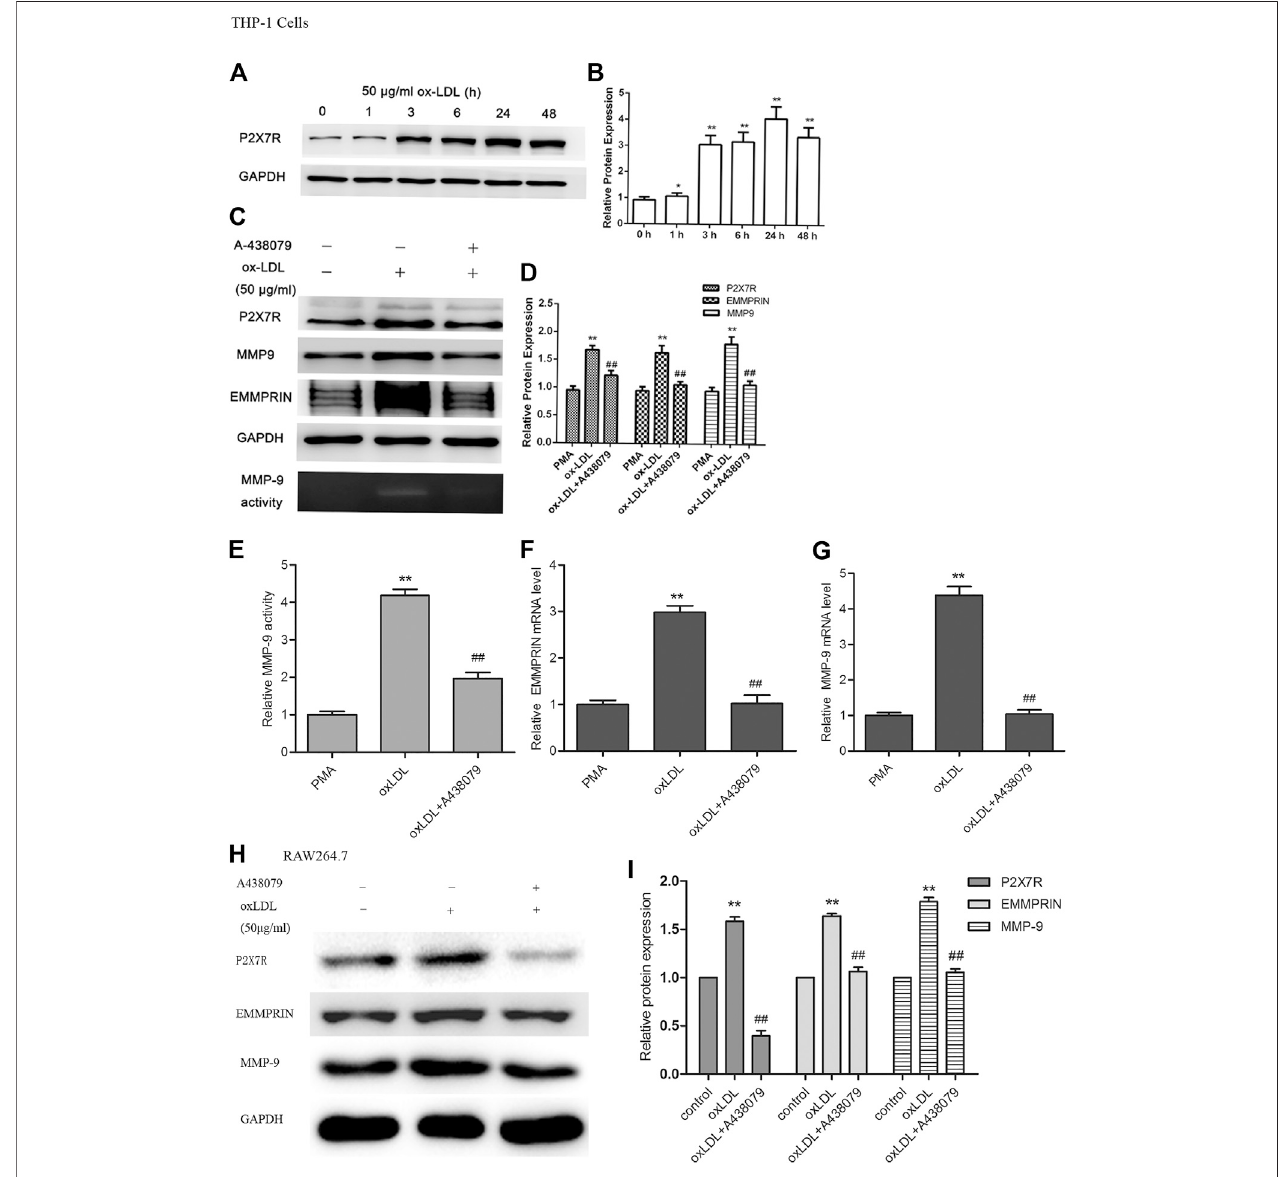
FIGURE1| ExpressionofP2X7RandtheeffectofA-438079onEMMPRINandMMP-9levelsinoxLDL-inducedmacrophages.EMMPRINandMMP-9proteinand mRNA levels were measured by Western blot and real-time PCR, respectively. MMP-9 activity was tested by gelatin zymography. Representative real-time PCR, WesternblotandzymographyresultsofMMP-9orEMMPRIN expression areshown. (A) oxLDLinducedP2X7Rinatime-dependent mannerinmacrophages. C.Effect of A-438079 on EMMPRIN and MMP-9 levels in THP-1 cells. (B,D,F,G) Representative real-time PCR results of MMP-9 mRNA analysis and densitometric measurement results of EMMPRIN and MMP-9 protein levels. (E) Densitometric measurement results of MMP-9 activity. H and I. EMMPRIN and MMP-9 expression by A-438079inRAW264.7murinecells.ThebanddensitiesweremeasuredbyQuantityOne1Danalysissoftware.Thedatarepresentthemean ± S.D.* p < 0.05,** p < 0.01 compared with the PMA or control, ## p < 0.01 compared with the oxLDL group.